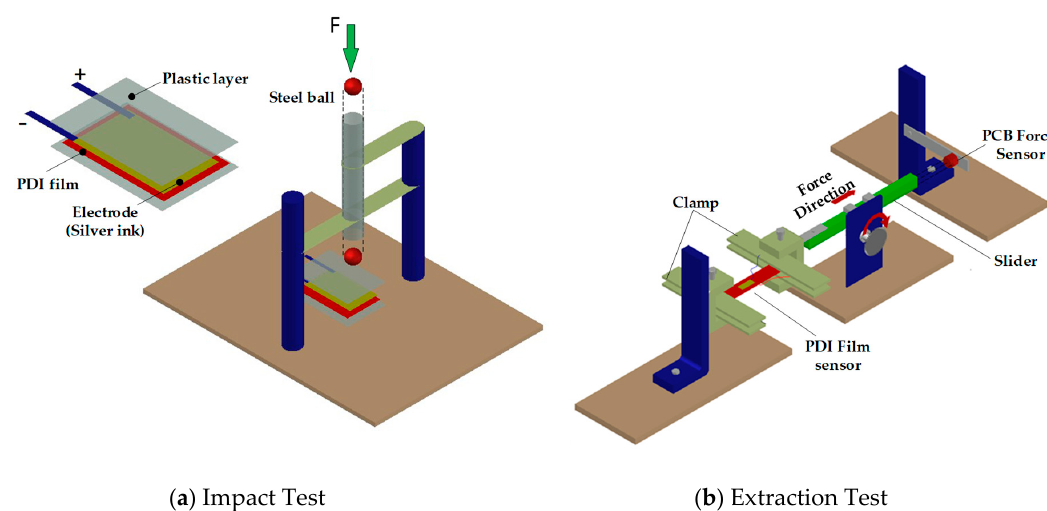
Figure 2. Test setup for measurement of piezoelectric coefficient ( a ) d 33 , ( b ) ( d 31 ) [39].